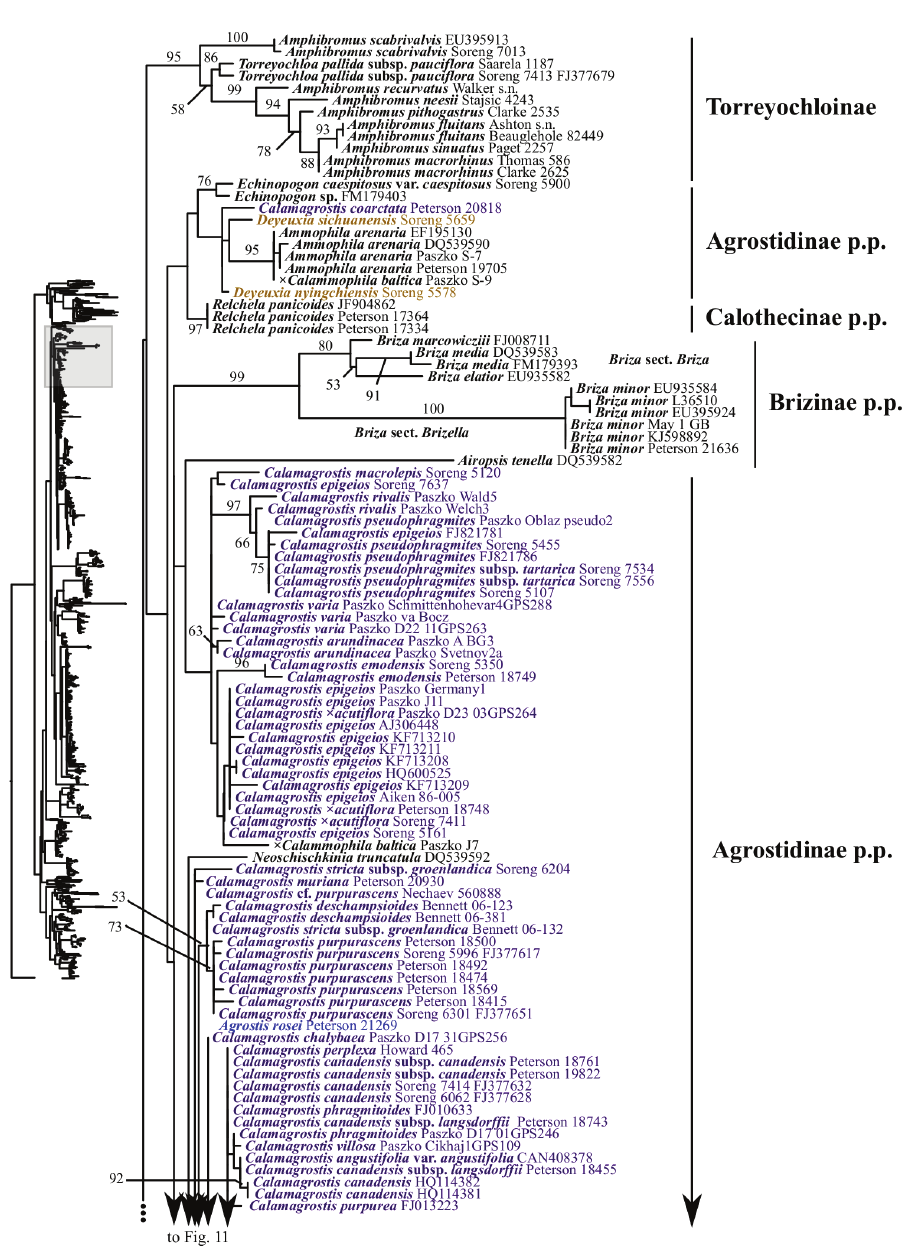
Figure 10. A portion (part of Agrostidinae p.p., Brizinae p.p., Calothecinae p.p. and Torreyochloinae) of the maximum likelihood phylogram inferred from ITS data. ML bootstrap support is recorded along branches when >50%. The shaded area of the smaller tree on the left indicates the location in the overall tree of the portion shown. Backbone branches represented by ellipses are shown only in Figure